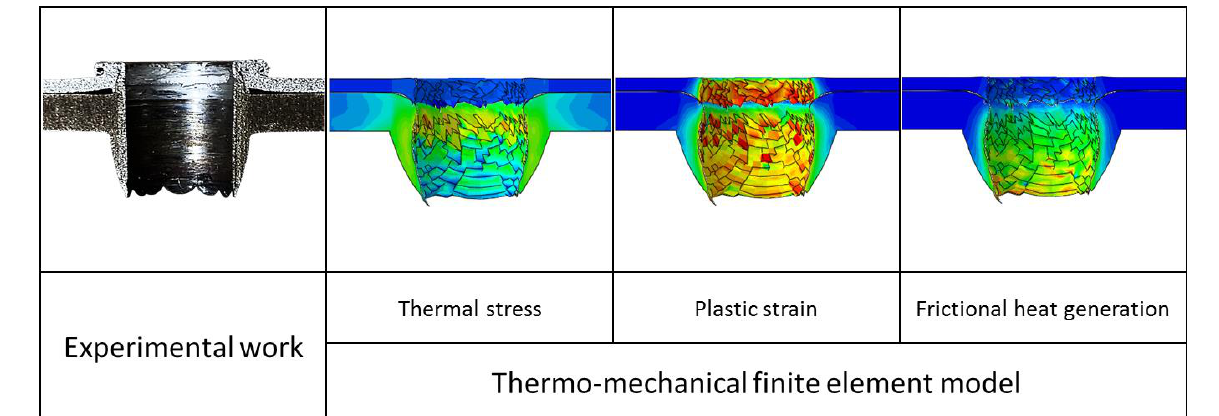
Figure 26. Comparison of experimental friction-drilled joint versus numerical predicted thermal stress, plastic strain, and frictional heat generation.